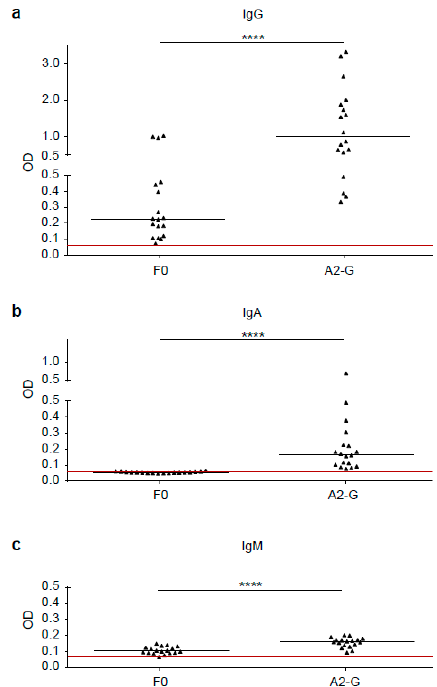
Figure 6. Comparison of G and F0-specific human IgG, IgM and IgA responses. Shown are IgA ( b ) and IgM ( c ) levels (y-axes: optical density OD values) against A2-G and F0 measured by ELISA